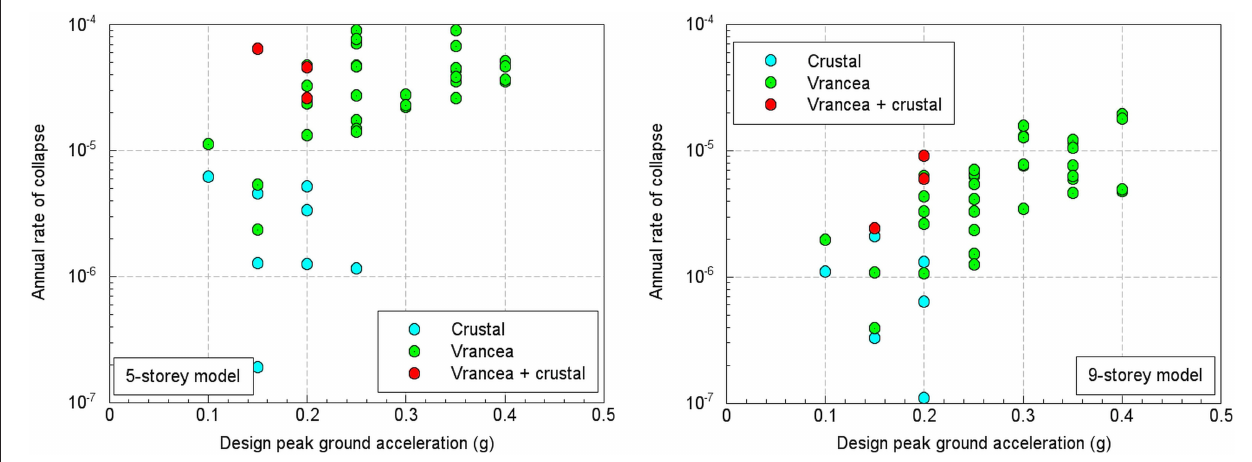
FIGURE 6 | Comparison of annual rate of collapse for the five-story model (Left) and nine-story model (Right) as a function of the design peak ground acceleration.